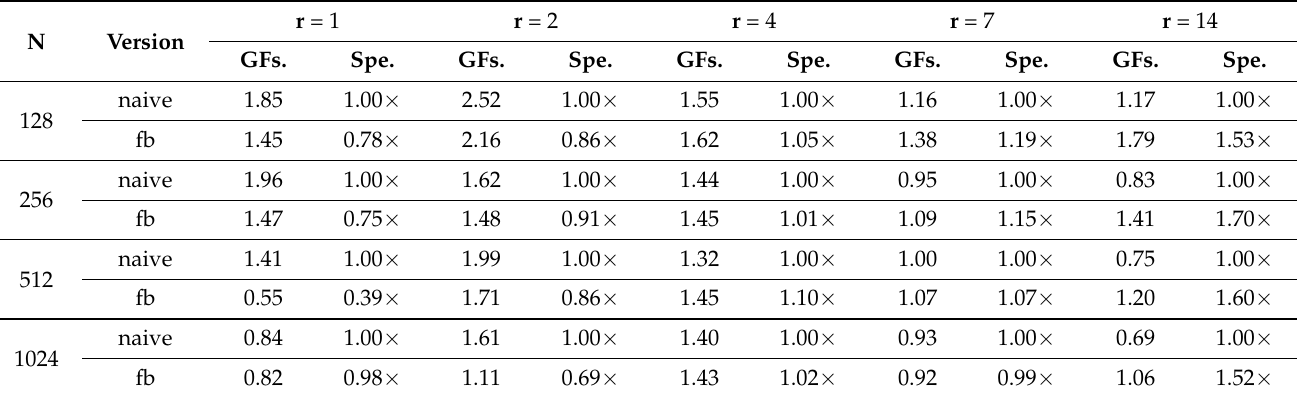
Table 5. Experimental results of the proposed transformation recipes: (g) forward and backward algorithm (ARM).